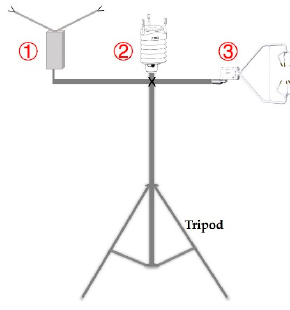
Figure 1. Diagram of the observation instruments above the sea surface: ① a micro-thermometer, ② an automatic weather station (WXT536), and ③ a three-dimensional ultrasonic anemometer (CSAT3).